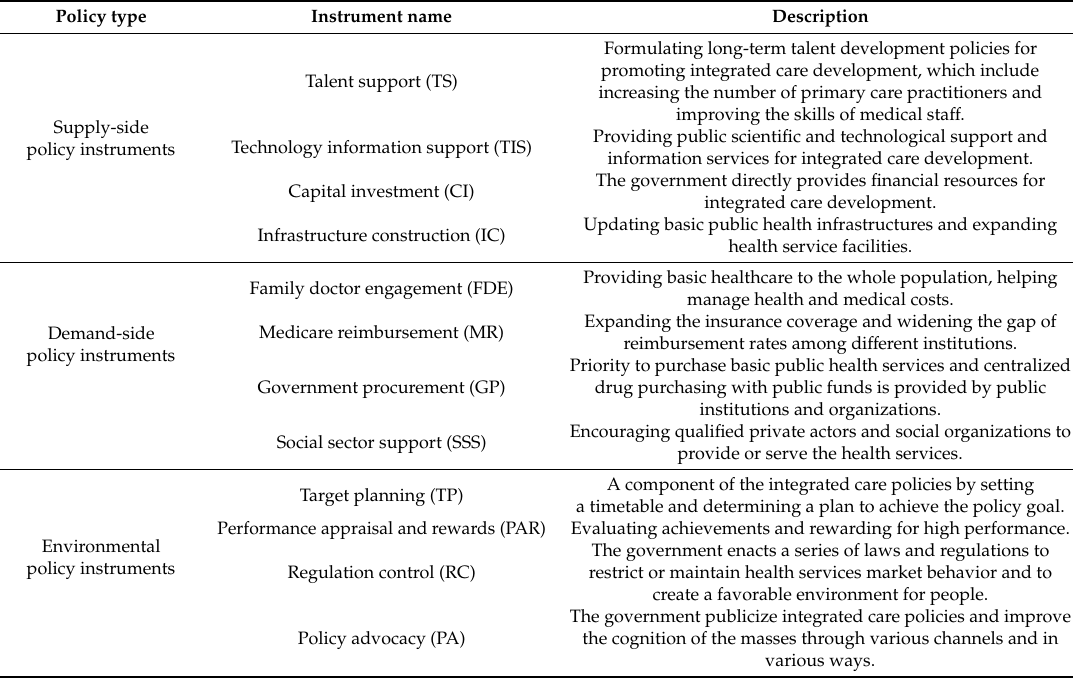
Table 1. The classification of policy